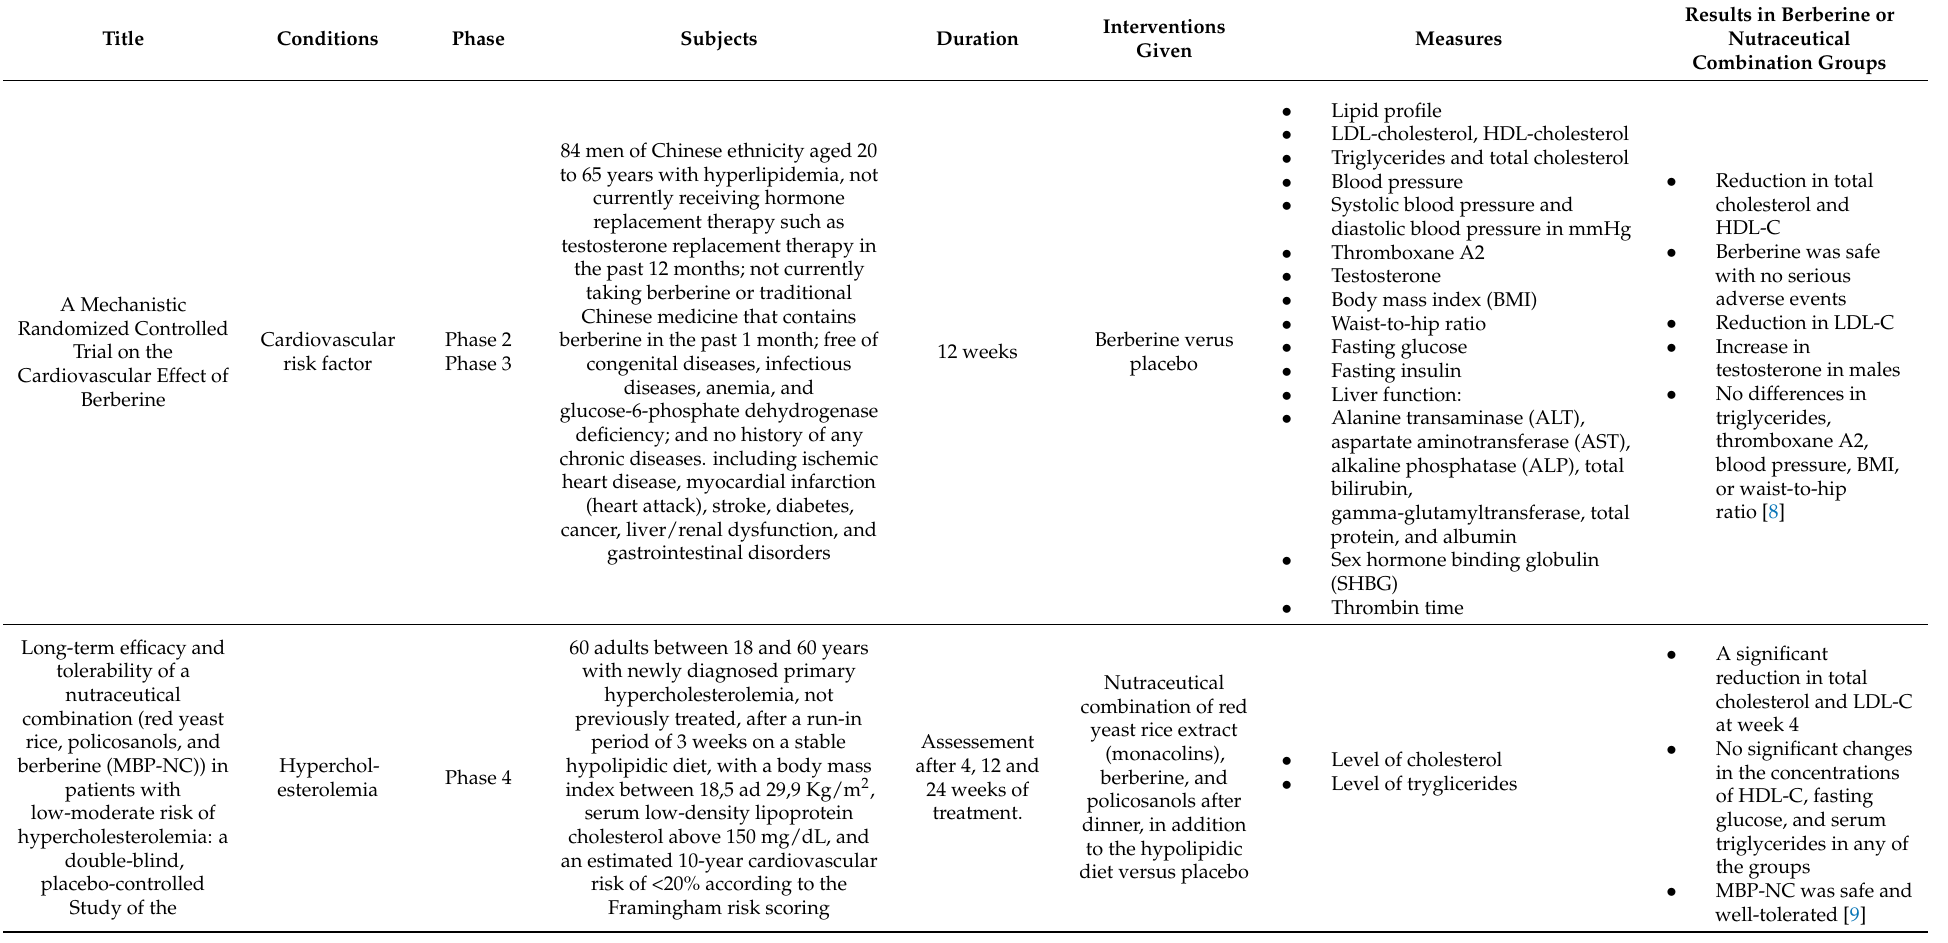
Table 1. Completed clinical trials with berberine in the metabolic syndrome based on clinicaltrials.gov (accessed on 10 Fabruary